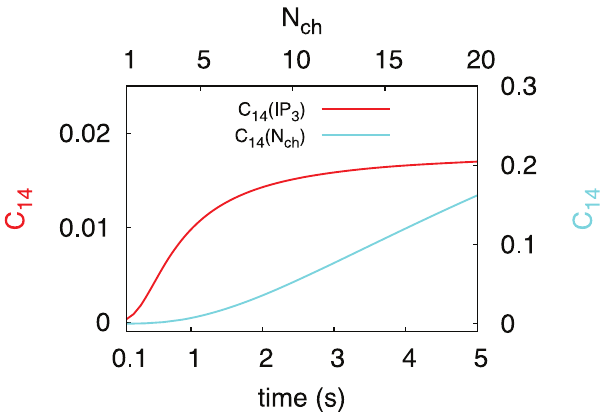
Figure 5. Parameter dependencies for the splitting probability C 14 to reach the spiking state S 4 out of a single puff state S 1 for the tetrahedron model. Note the different axis scaling for the cytosolic IP 3 concentration and the mean number of Ca 2 z channels per cluster participating in an opening event ( N ch ) respectively. The splitting probability saturates for both parameters, however for the N ch dependency only for a unrealistic high number of Ca 2 z channels